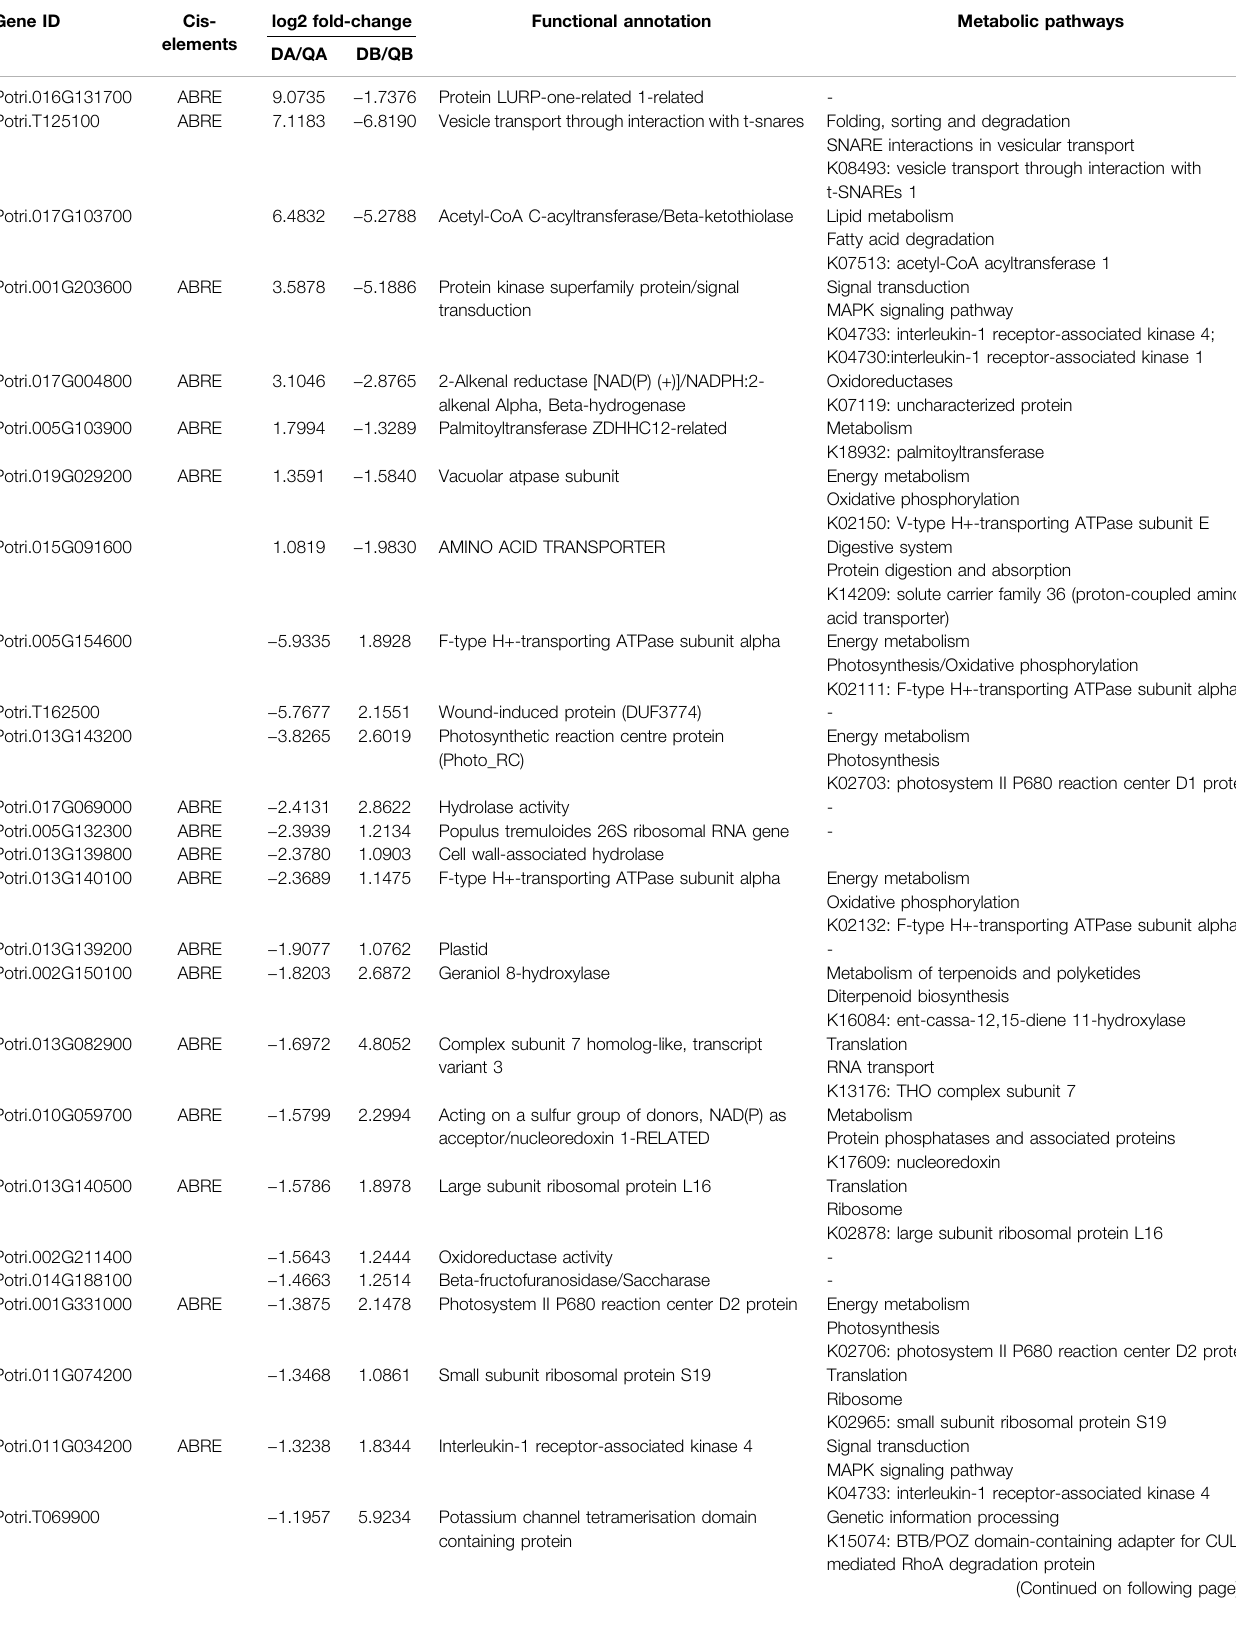
TABLE 4 | Analysis of DGEs induced by introduction of the JERF36 gene in comparisons of the transcriptomes of Daqing to Qiqihar from ABJ01 and